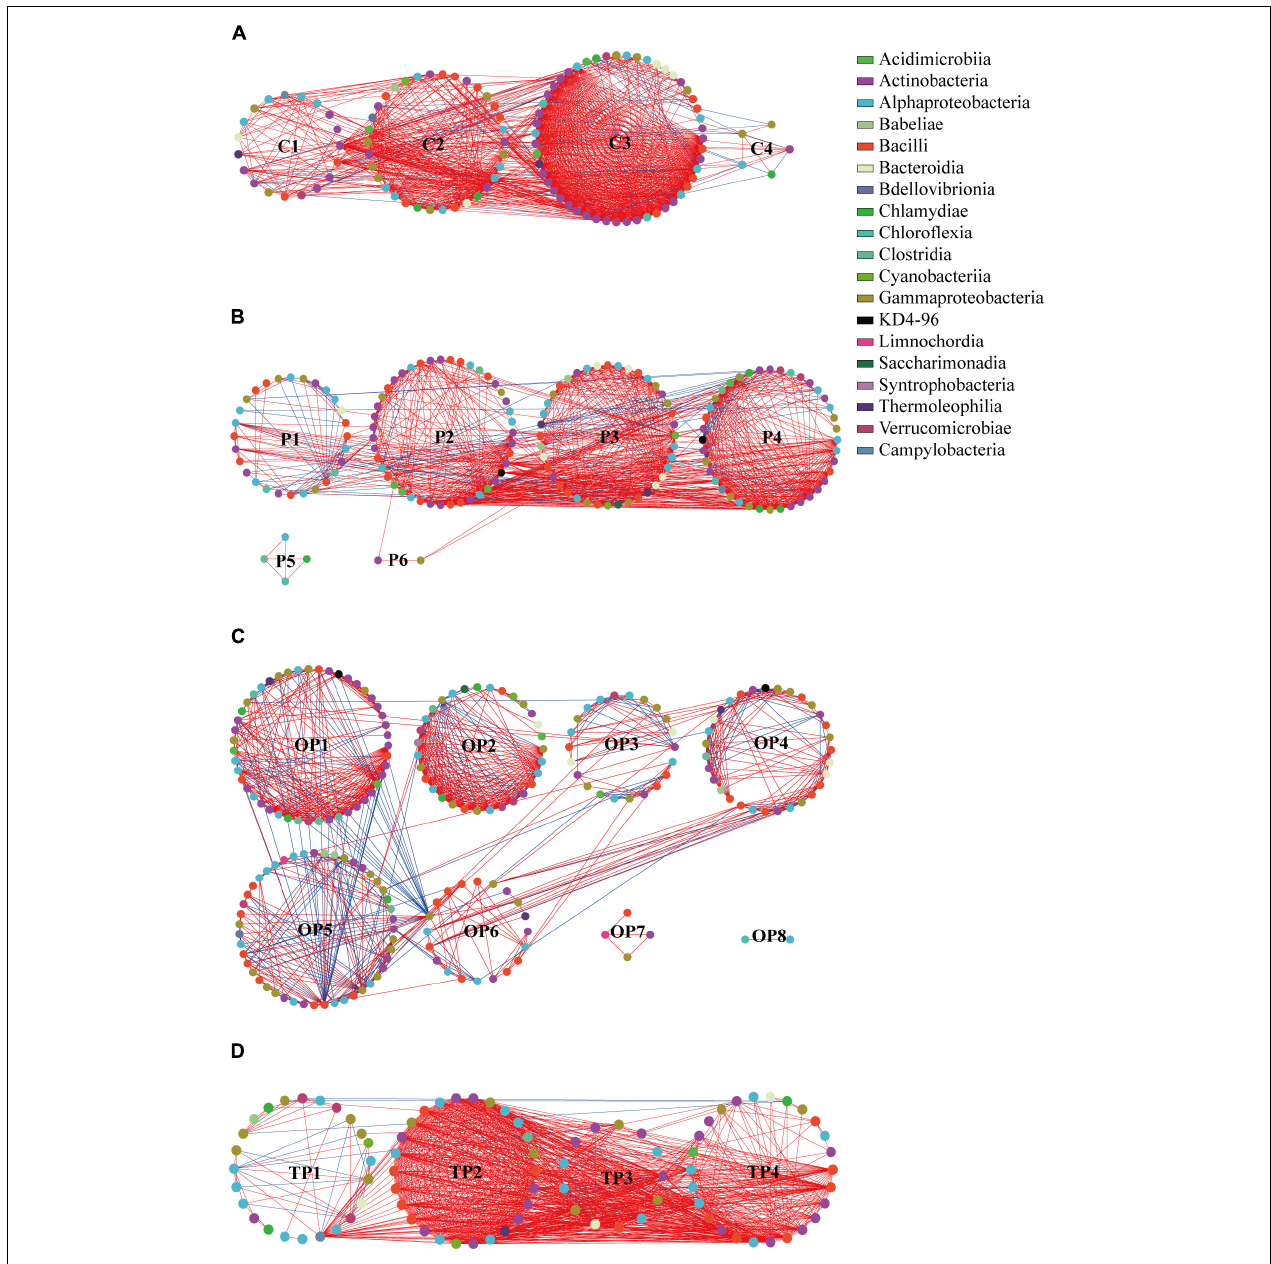
FIGURE 7 | Network analysis of the intestinal microbiota in sea cucumbers. Each node indicates one OTU. Different colored nodes represent different classes. A red link indicates positive interaction between two individuals, while a blue link indicates negative interaction. (A) C treatment network, (B) P treatment network, (C) OP treatment network, and (D) TP treatment network. C (control): basal diet; P: basal diet supplementation with 0.5% PHB; OP: basal diet supplementation with 1% PHB; TP: basal diet supplementation with 3%